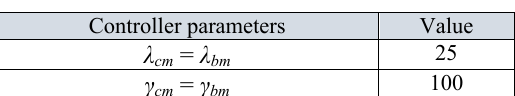
Table 3. Control parameters